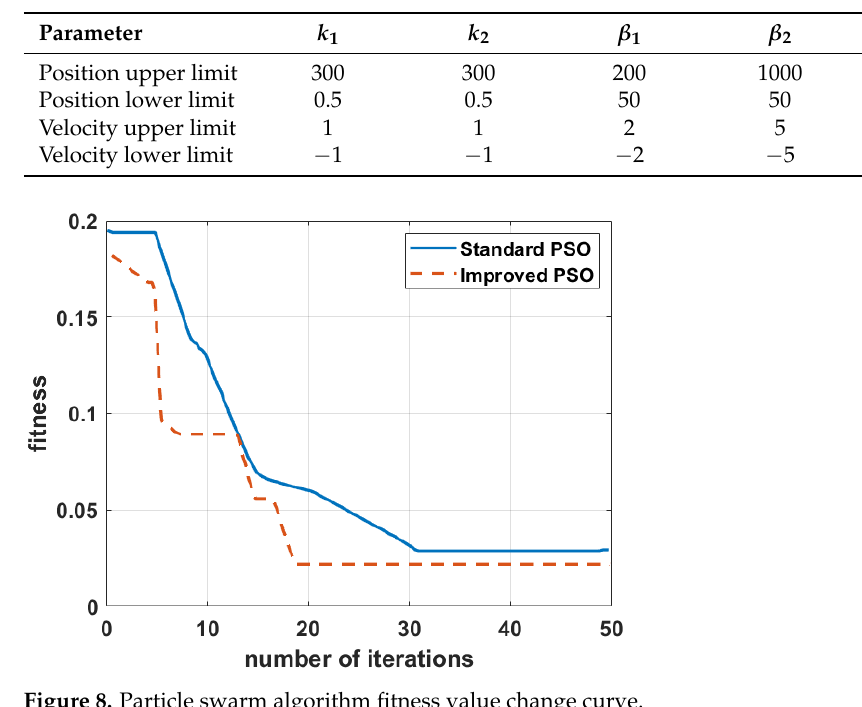
Table 3. Initialization parameter of particle swarms.